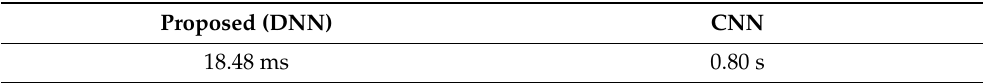
Table 5. Comparison of computation time per